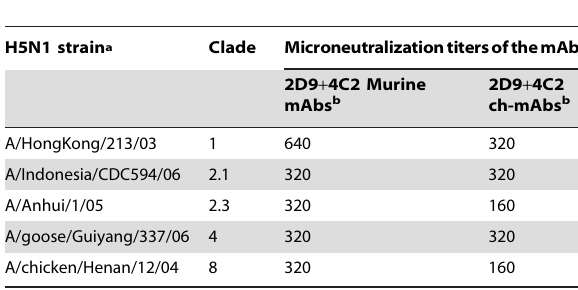
Table 3. Microneutralization titers of the murine and chimeric mAbs against H5N1 influenza